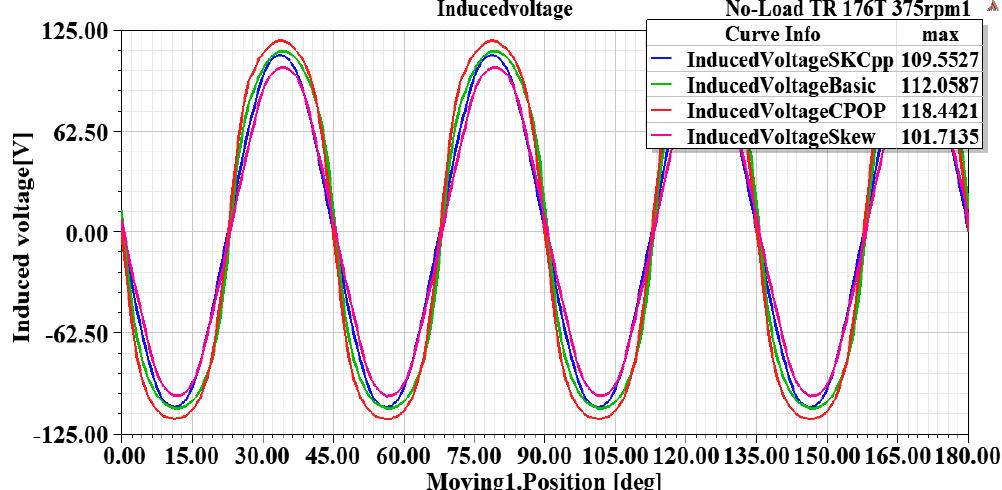
Figure 26. Induced voltage waveforms comparison at transient no-load.